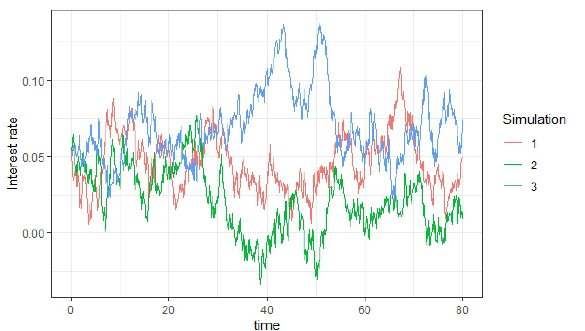
Figure 3. Simulations of the interest rate in the numerical example.